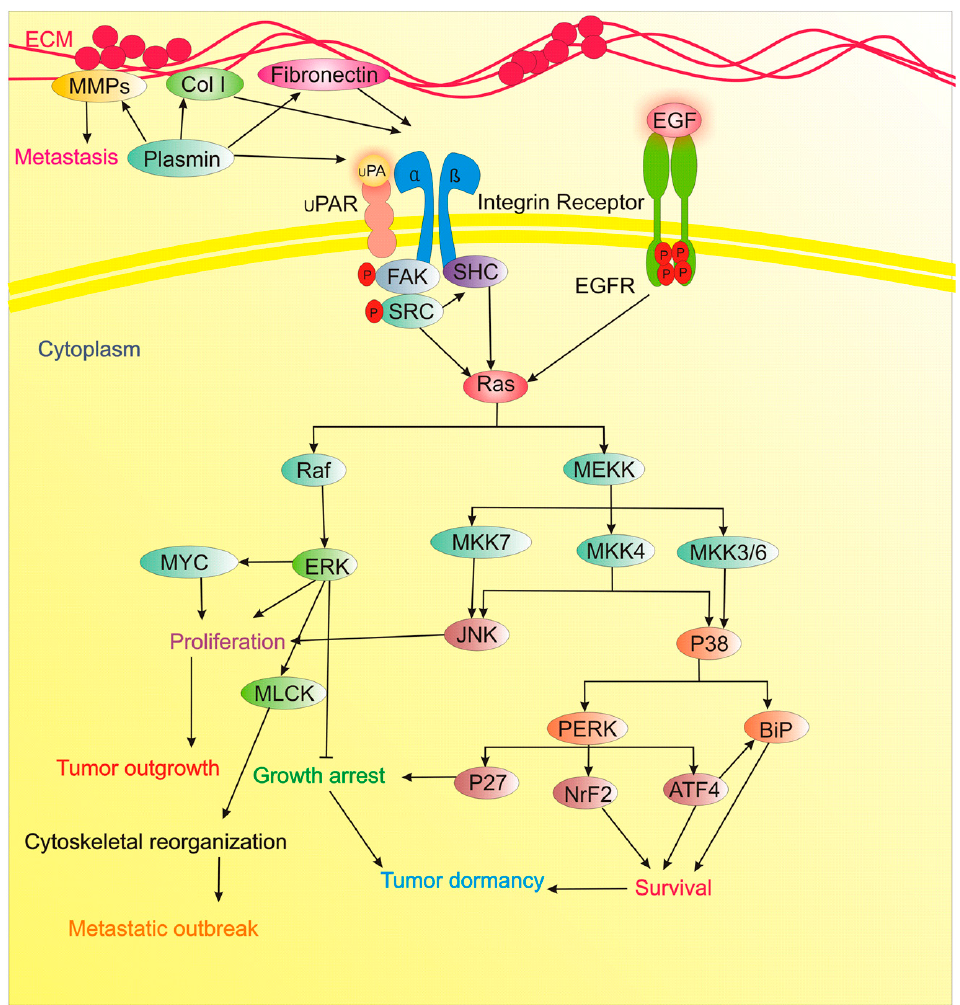
Figure 2. The implication of ECM and p38 signaling in tumor dormancy.